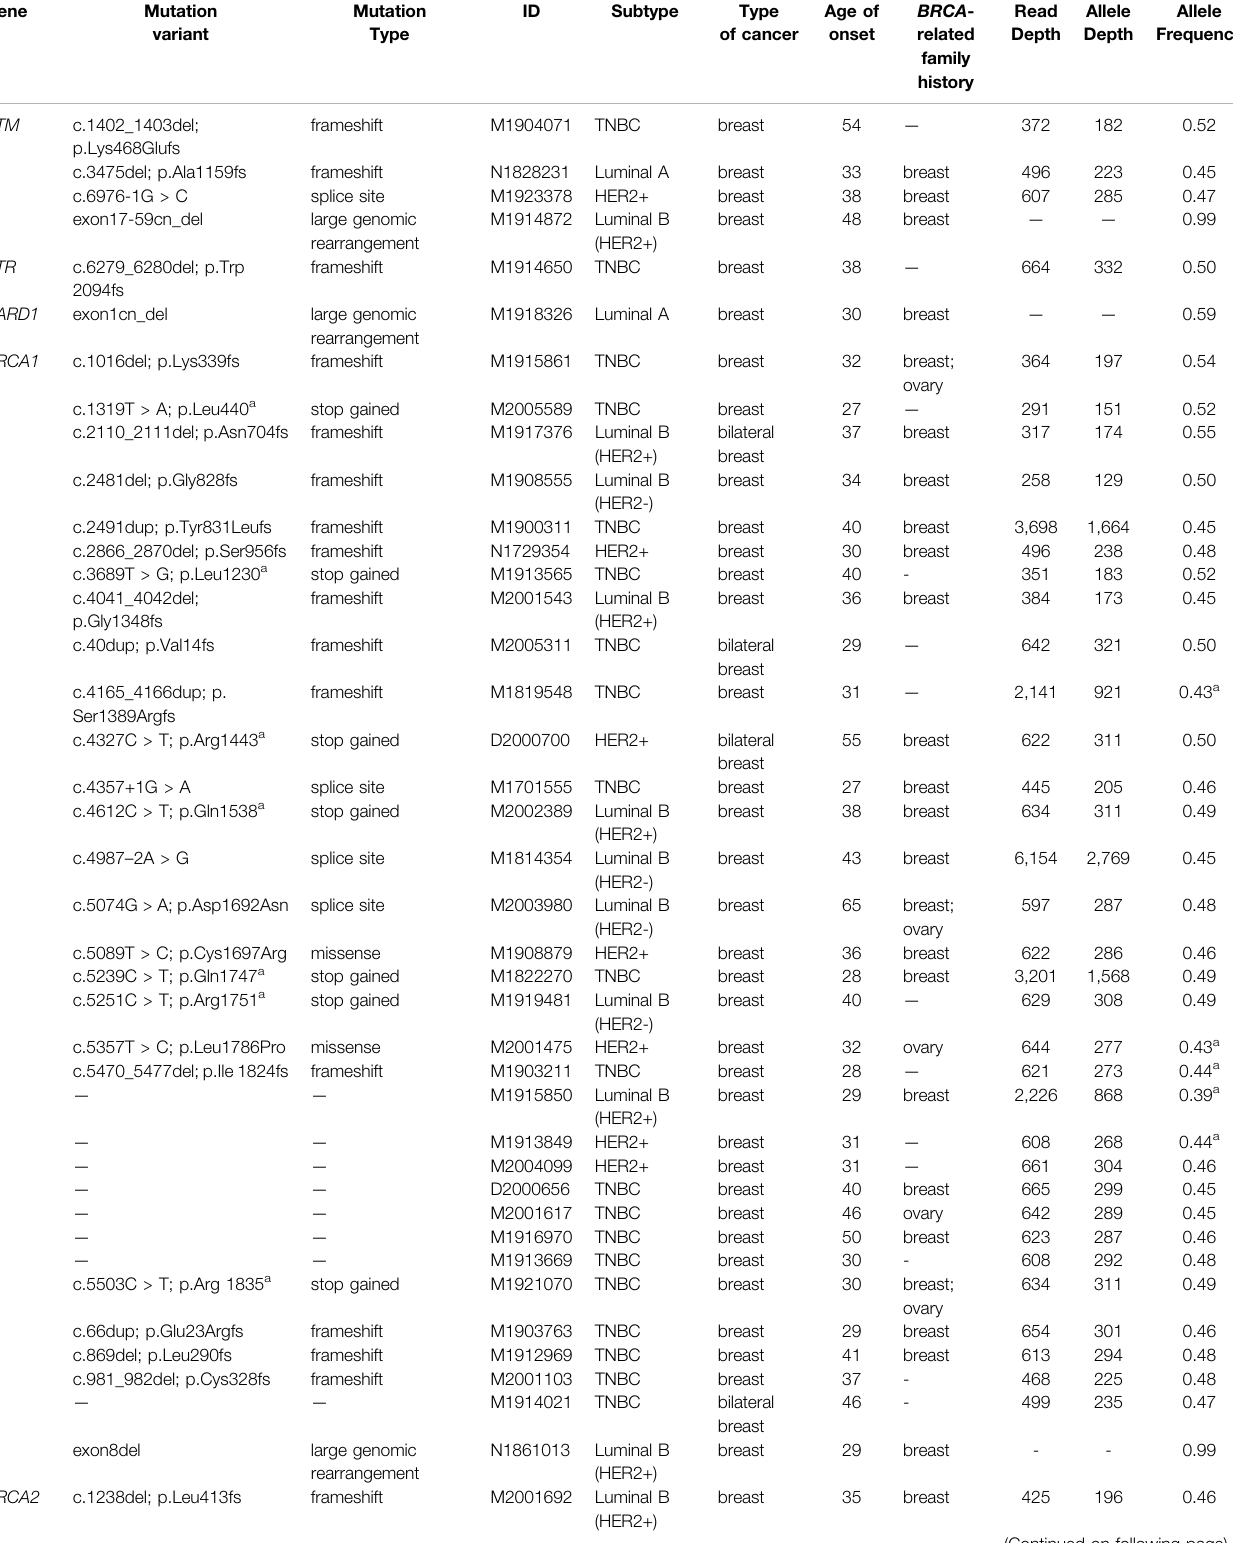
TABLE 5 | List of pathogenic/likely pathogenic variants in 68